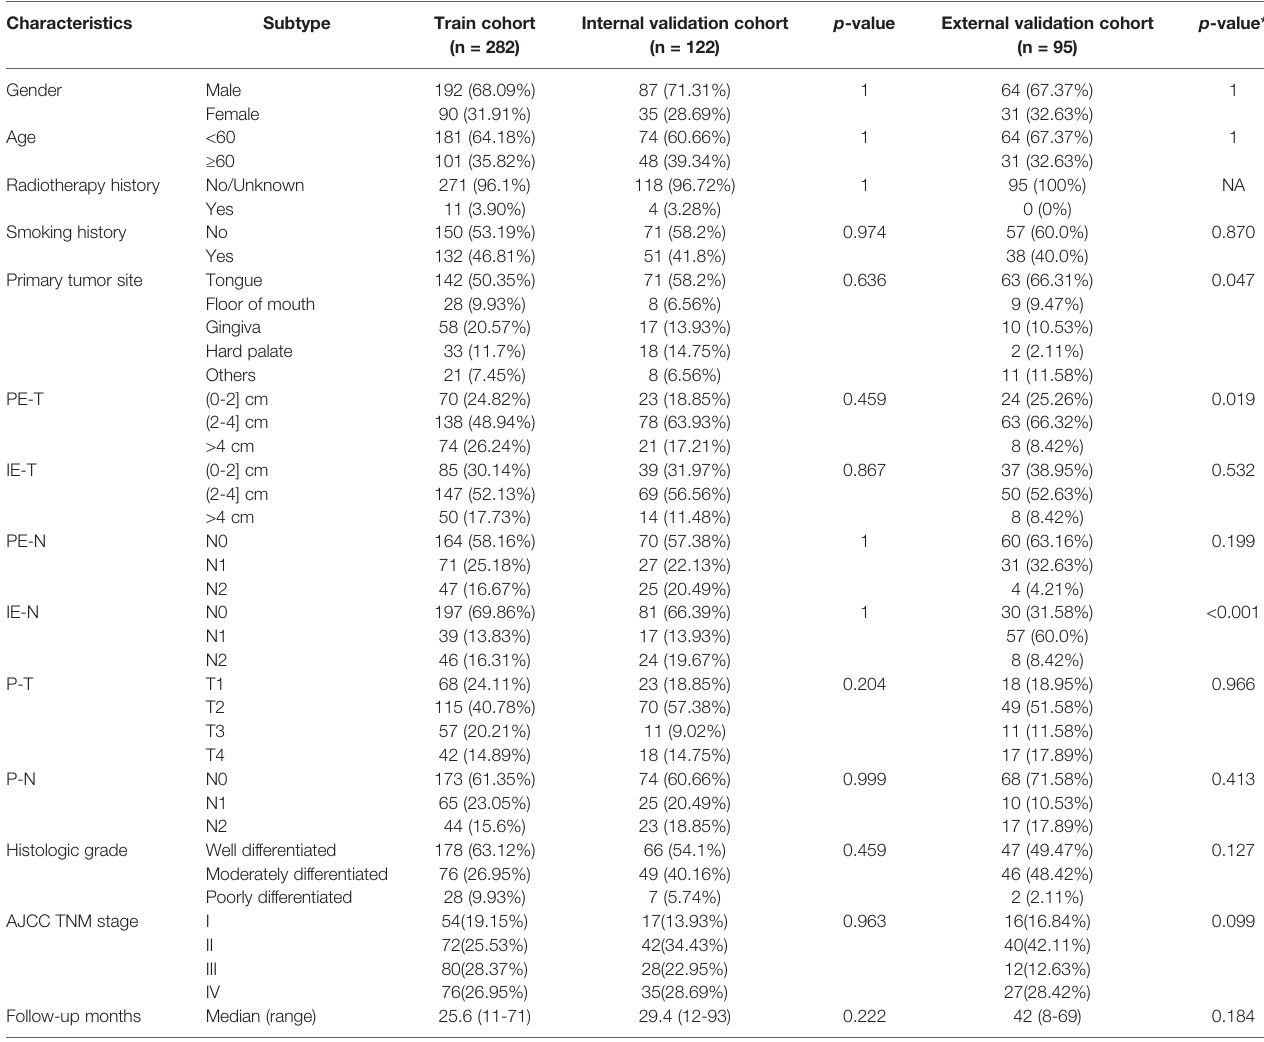
TABLE 1 | Characteristics description in the training and validation